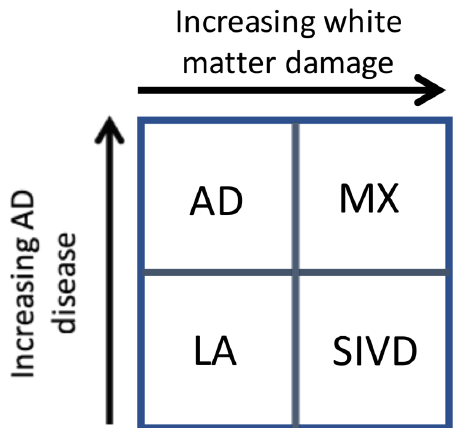
Figure 2. Classification of patients into diagnostic groups with a double dichotomy approach based on CSF studies and MRI DTI being on separate axes. On the y -axis there is increasing values for CSF Alzheimer protein with low levels of leukoaraiosis (LA) and high levels in Alzheimer’s disease (AD). On the x -axis, there are increasing values for MRI DTI with the lowest values in the LA group and the highest values in subcortical ischemic vascular disease (SIVD). When the DTI is high and the CSF proteins are high, the patient is diagnosed as mixed dementia (MX).